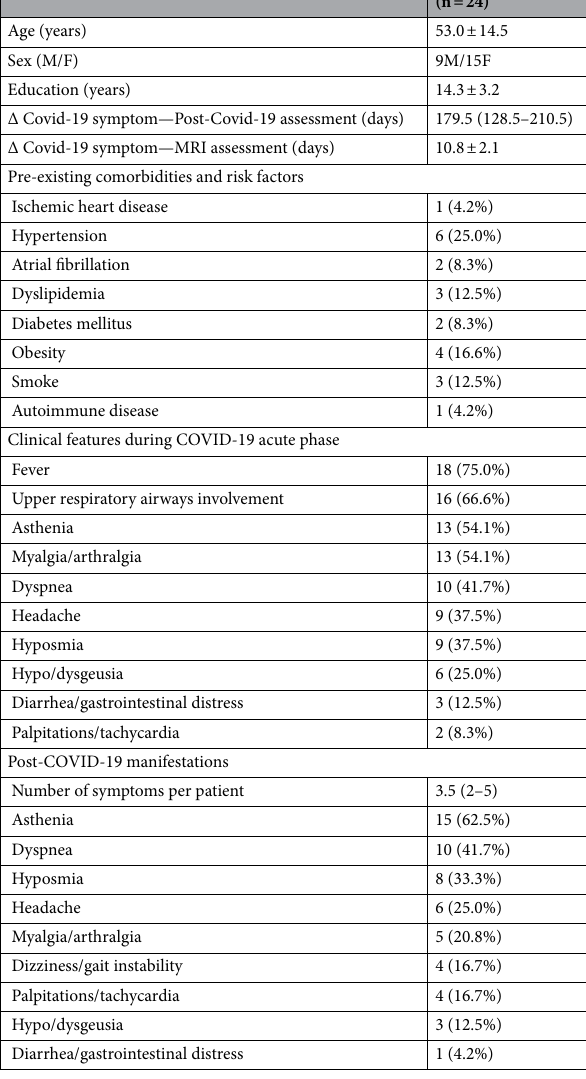
Table 1. Demographic and clinical characteristics of post-COVID-19 patents.